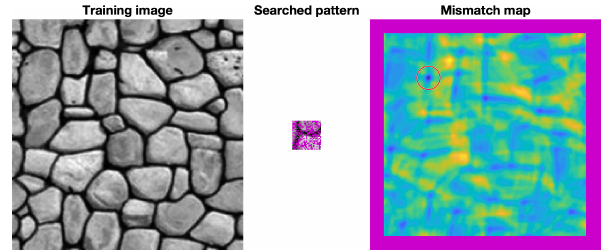
Figure 1. Example of a mismatch map for an incomplete pattern. Blue represents good matches, yellow bad matches, and purple missing and unusable (border effect) data. The red circle highlights the minimum of the mismatch map, which corresponds to the loca- tion of the best